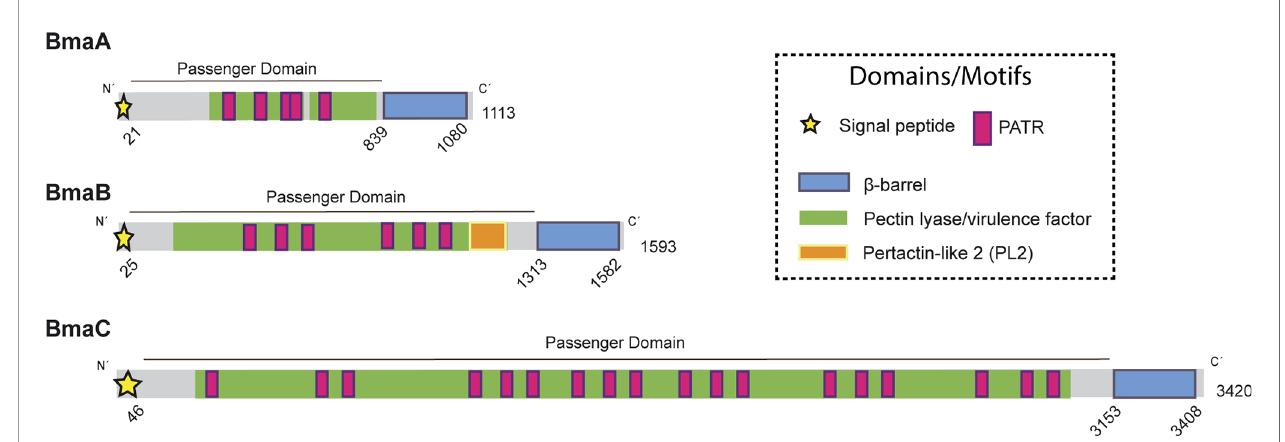
FIGURE 1 | Domain organization of Bma proteins. Schematic representation of BmaA, BmaB, and BmaC, showing functional and structural domains predicted by bioinformatics (SignalP 5.0, Pfam, BLAST). Numbers indicate amino acid positions of the predicted signal peptide, b -barrel domain, and total length of the protein. Modi fi ed from Bialer et al.,